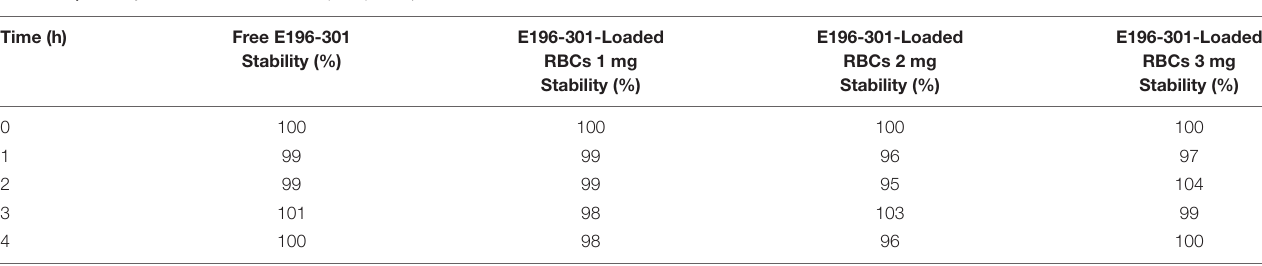
TABLE 3 | Stability of free or red blood cell (RBC) encapsulated